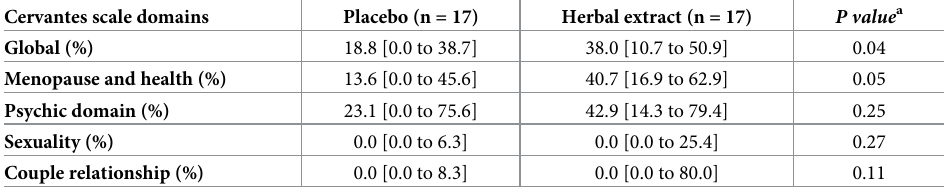
Table 2. Percentage improvement in global score and domains between groups after treatment using the self- reported Cervantes Scale. Cervantes scale